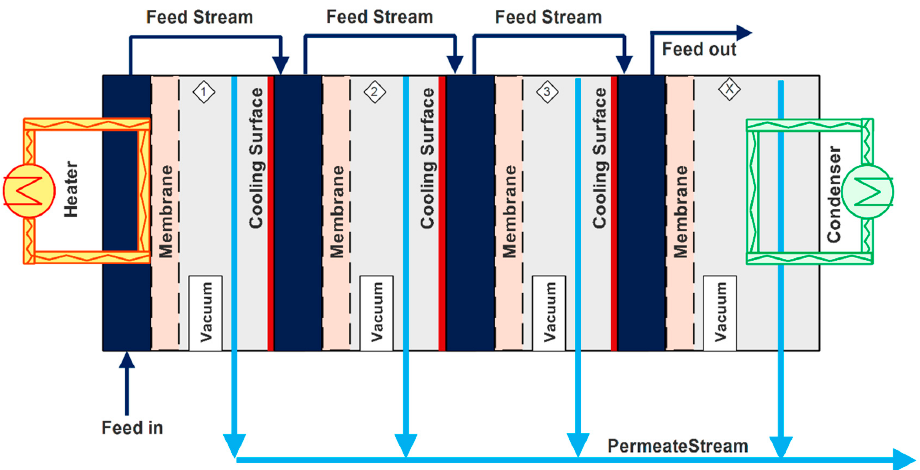
Figure 6. Schematic diagram of vacuum multi ‐ effect membrane distillation (V ‐ MEMD) [19] .